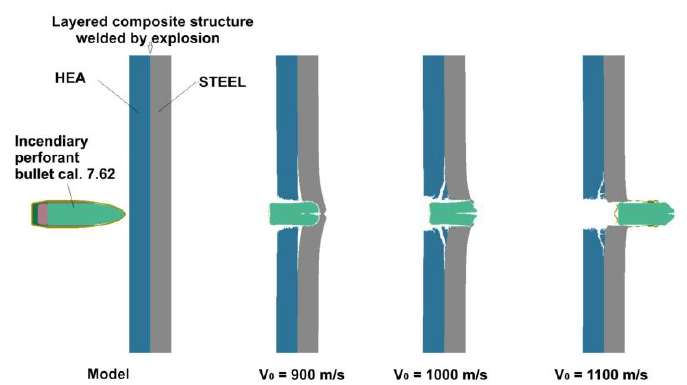
Figure 12. The behavior of the HEA-STEEL composite structure, welded by explosion, at impact with an incendiary armor piercing bullet (7.62 mm caliber) with different initial speeds.